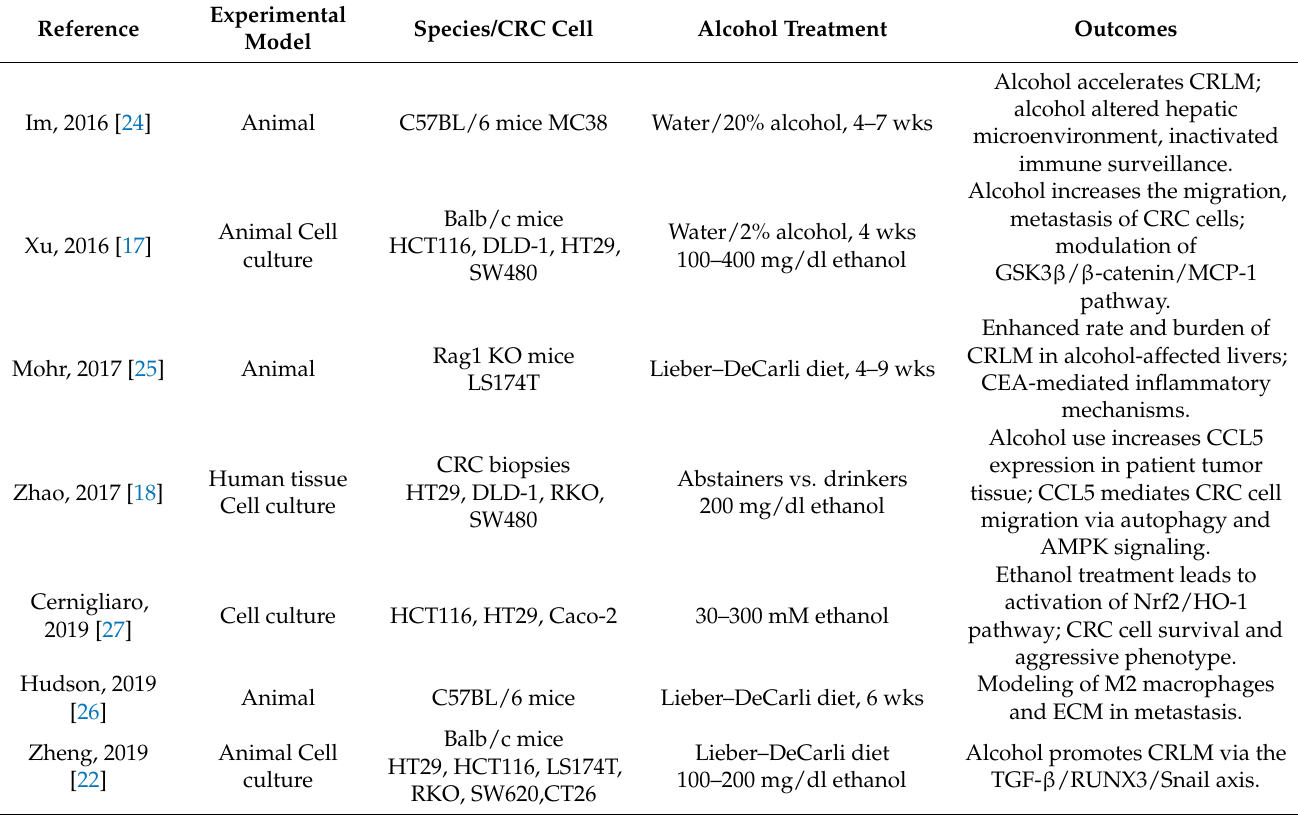
Table 3. Characteristics of preclinical studies.